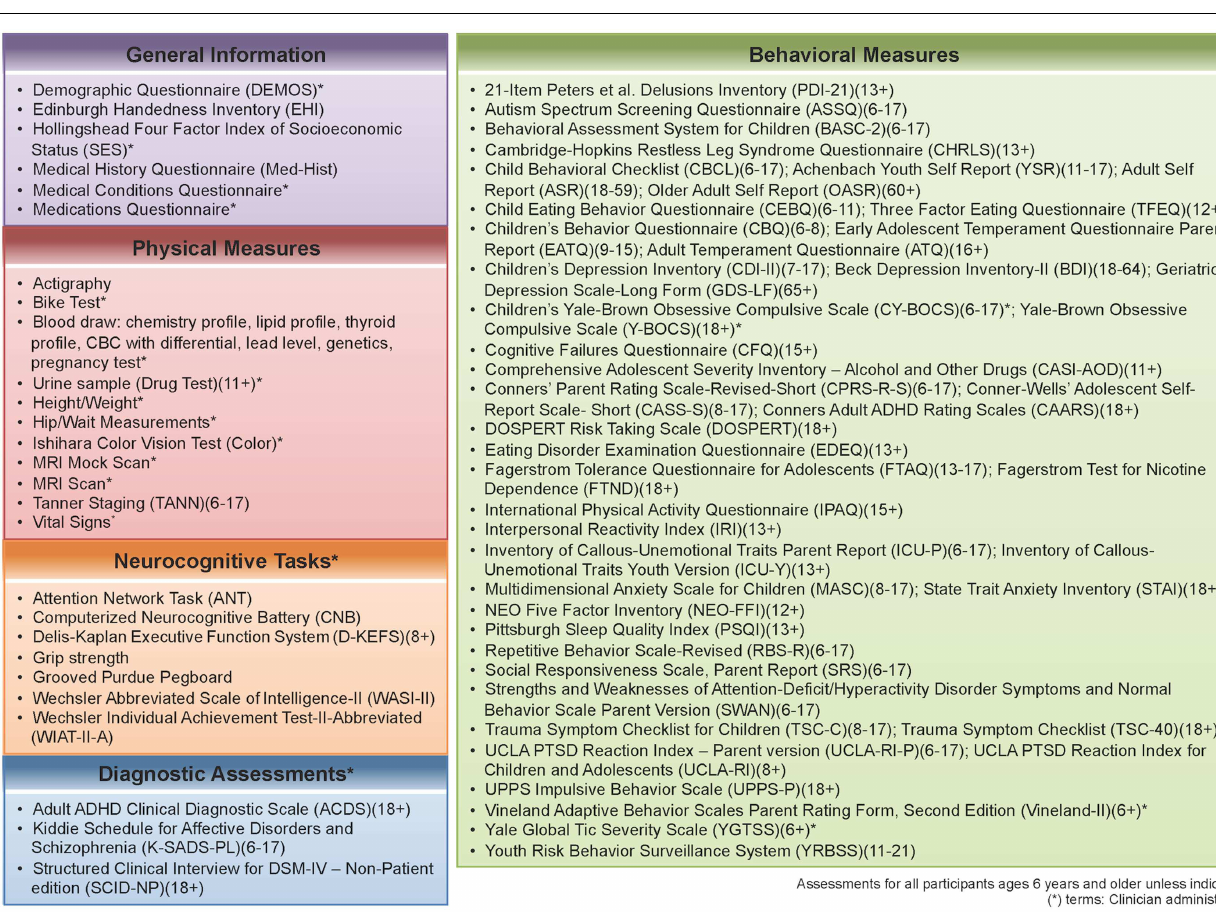
assessment: General, Physical, Neurocognitive, Diagnostic, and Behavioral. Within the table are the names, abbreviations, and age ranges in years for each of the